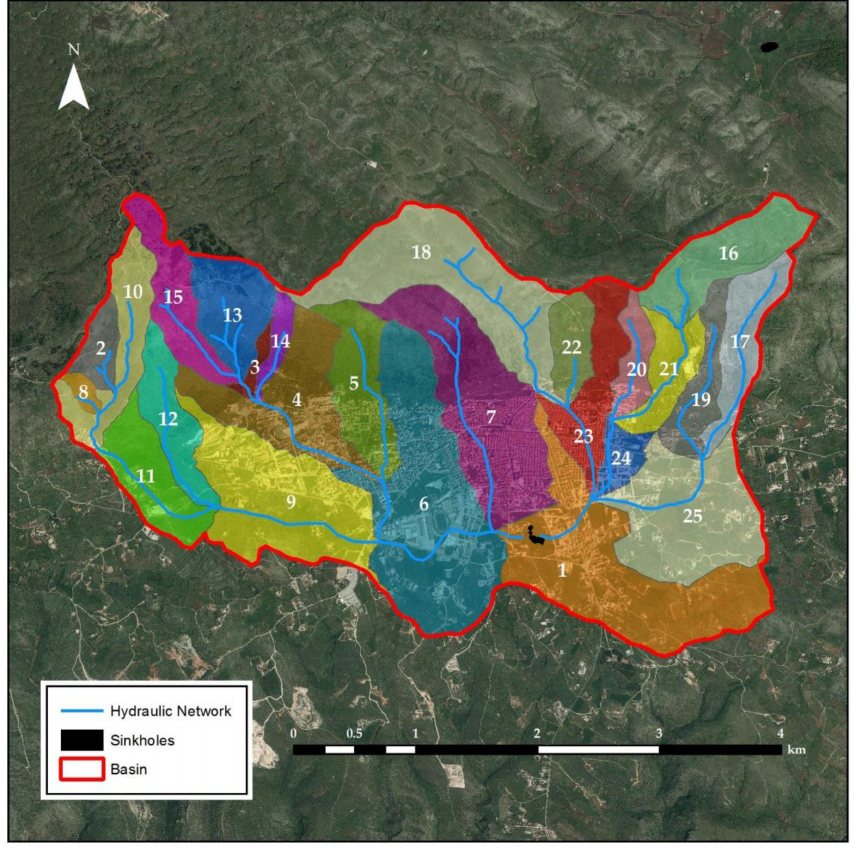
Figure 3. Sub-basins